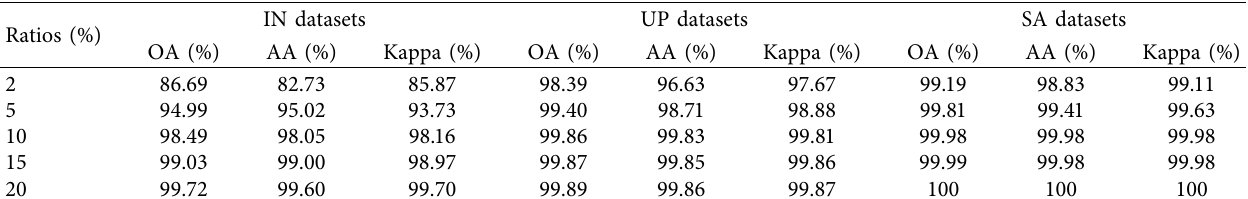
Table 2: Classification accuracy of different training sample